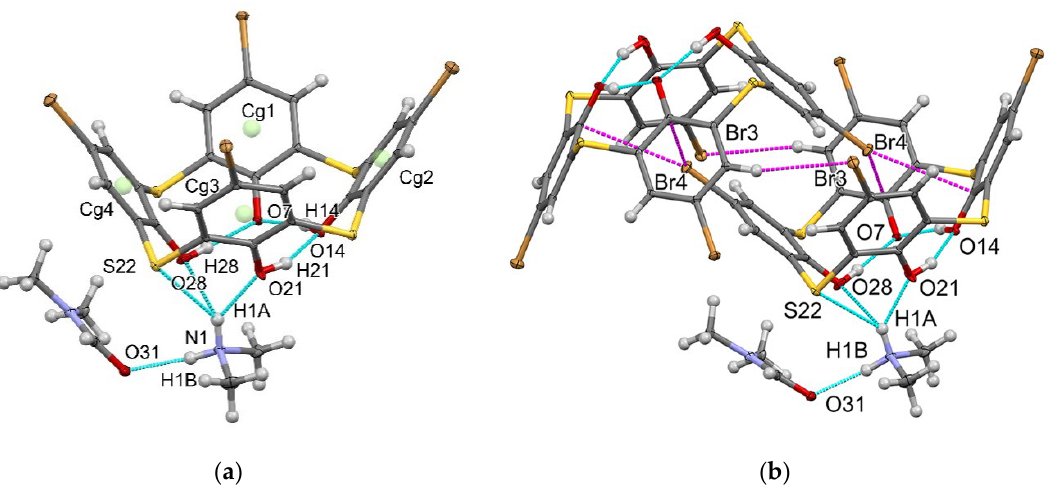
Figure 3. ( a ) O-H…O, N-H…O and N-H…S hydrogen bonds (blue dashed lines) ( a ) and Br…π; ( b ) C-H…Br interactions (magenta dashed lines) in the crystal H 3 L( 2 ) − ·(CH 3 ) 2 NH 2+